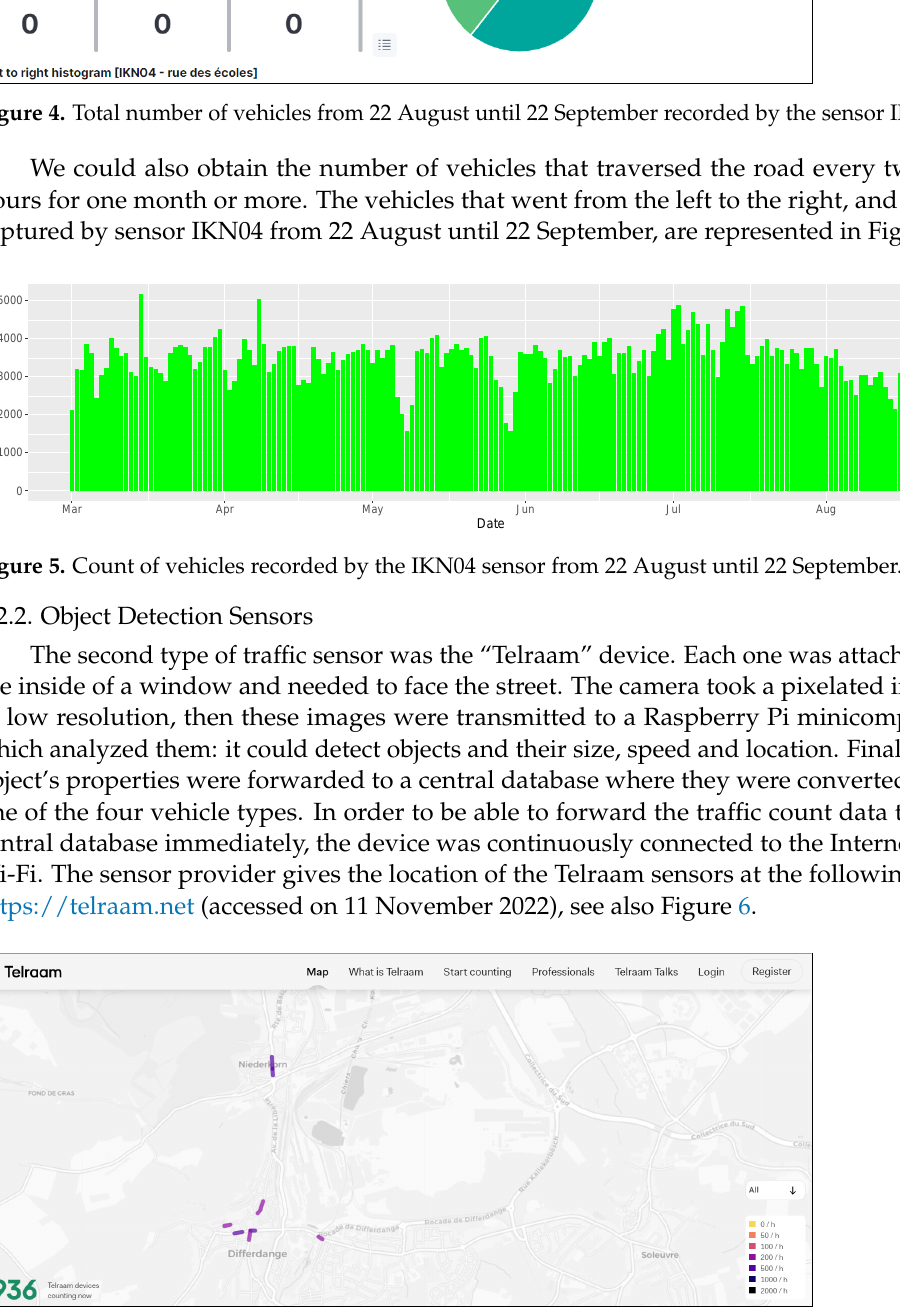
Figure 6. Locations of the eight Telraam